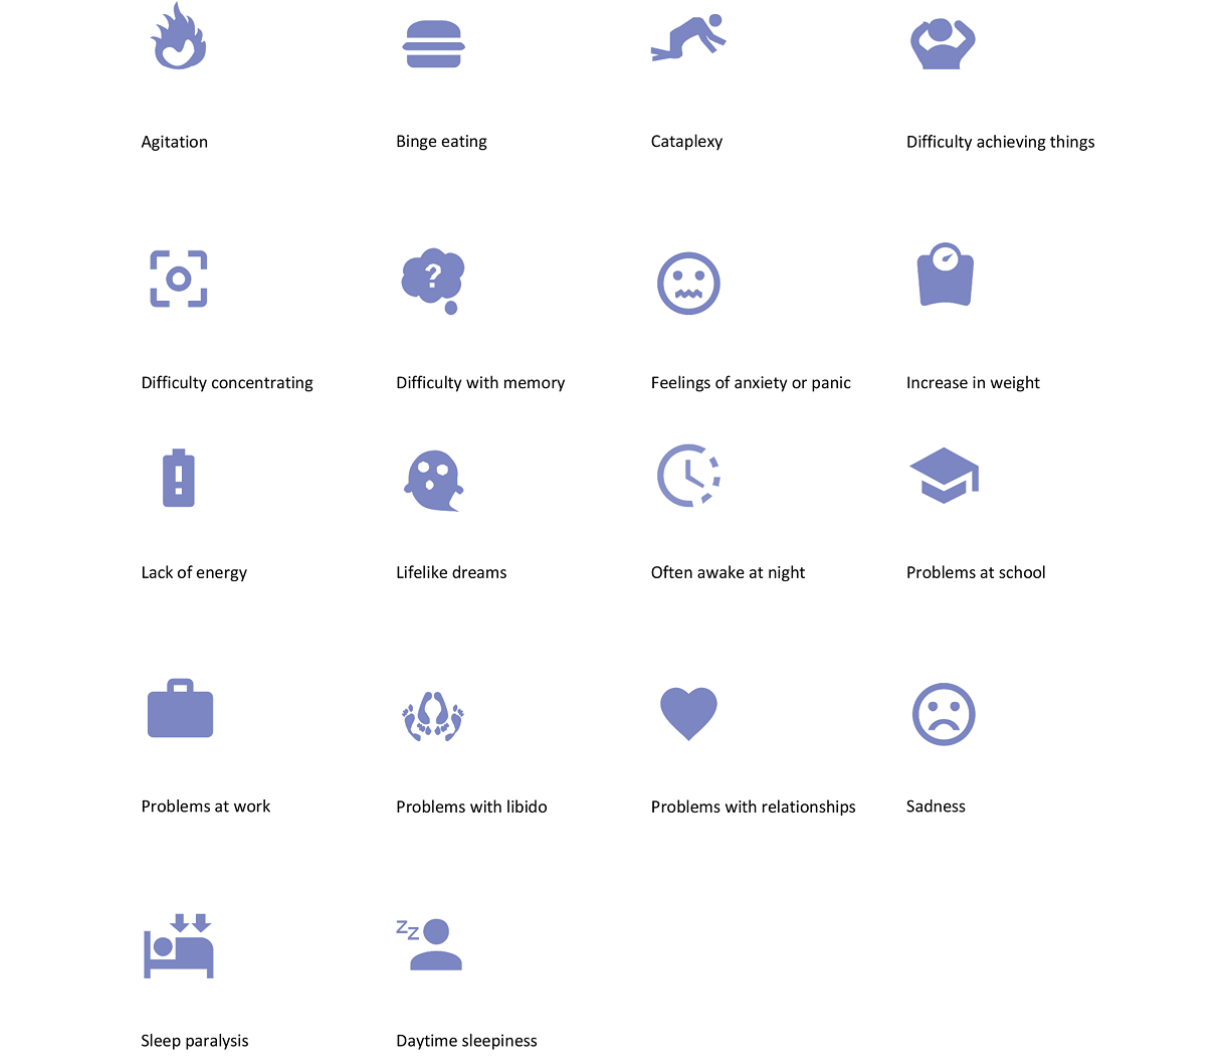
Figure 4. List of symptoms included in the Narcolepsy